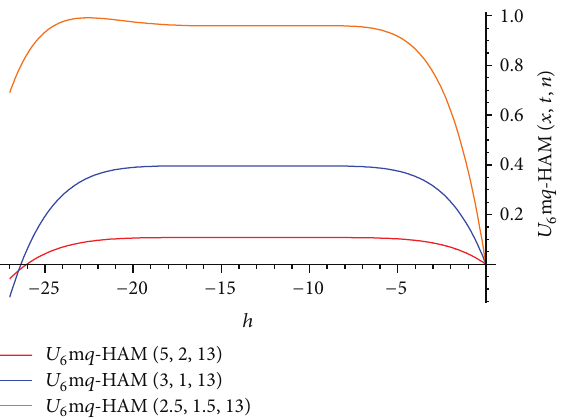
Figure 3: Comparison between 𝑈 6 of 𝑛 HAM (m 𝑞 -HAM; 𝑛 = 1 ) and 𝑞 -HAM ( 𝑛 = 5.5, 13, 30, 75) with exact solution of (28) at 𝑥 = 1 𝑈 6 m with (ℎ = −1, ℎ = −4.9, ℎ = −10.8, ℎ = −23.15, ℎ = −49.25) , respectively.